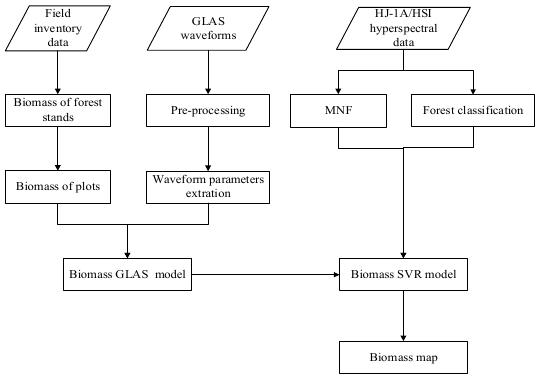
Figure 3. Flow chart of regional biomass estimation from GLAS, HJ-1A/HSI, and field data